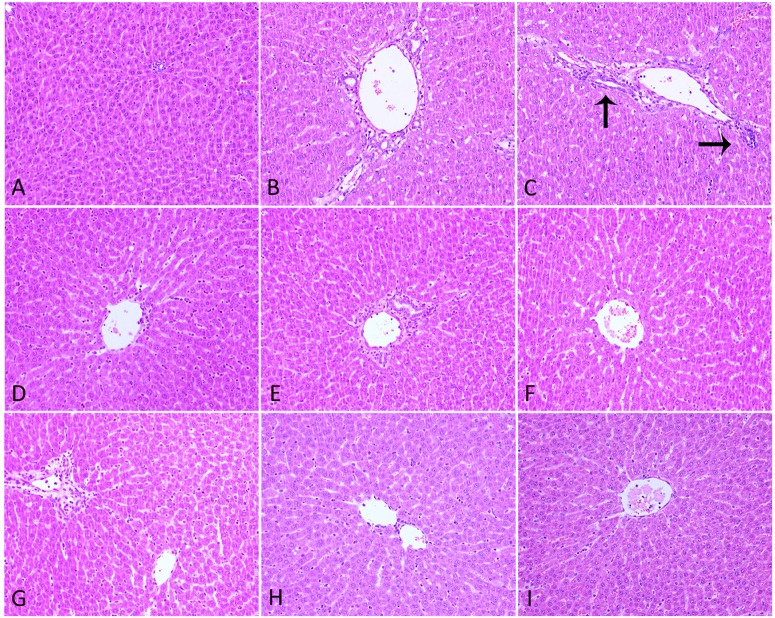
Histopathological damage in rat liver.
(A) Control group (Ctr), (B) LPS model group (LPS), (C) PM treated with LPS group (LPM), (D) high dose of Poria treated with LPS group (LHP), (E) middle dose of Poria treated with LPS group (LMP), (F) low dose of Poria treated group with LPS (LLP), (G) PM + high dose of Poria co-treated with LPS group (LPHP), (H) PM + middle dose of Poria co-treated with LPS group (LPMP), (I) low dose of Poria co-treated with LPS group (LPLP). Liver sections were collected at 7 h after LPS tail intravenously (HE stained, ×200 magnification).